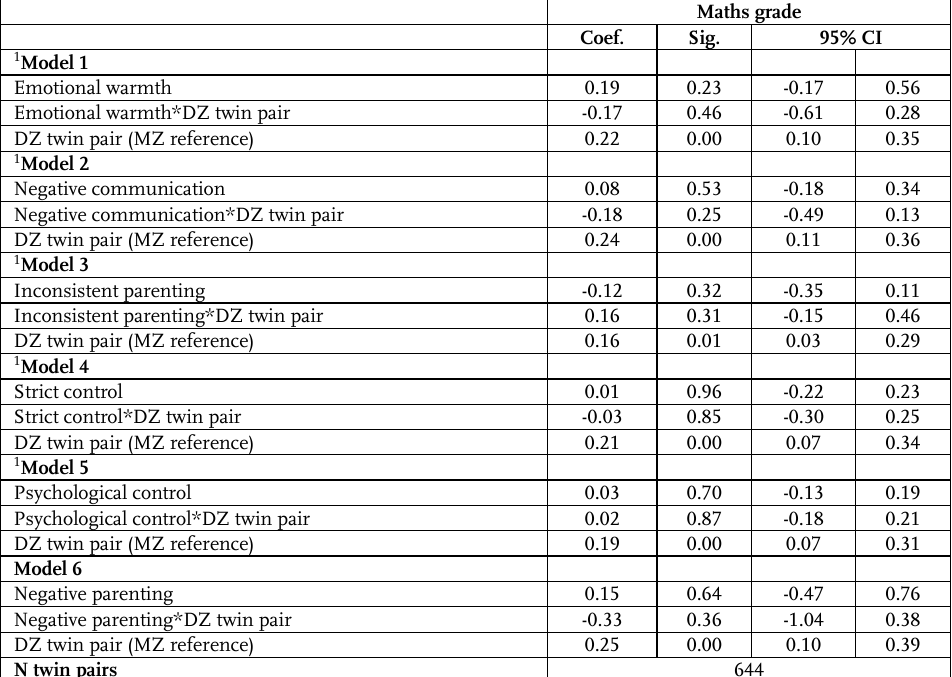
Table 8 : Regression output for the different models explaining trait differences in MZ and DZ twin pairs for twin pairs